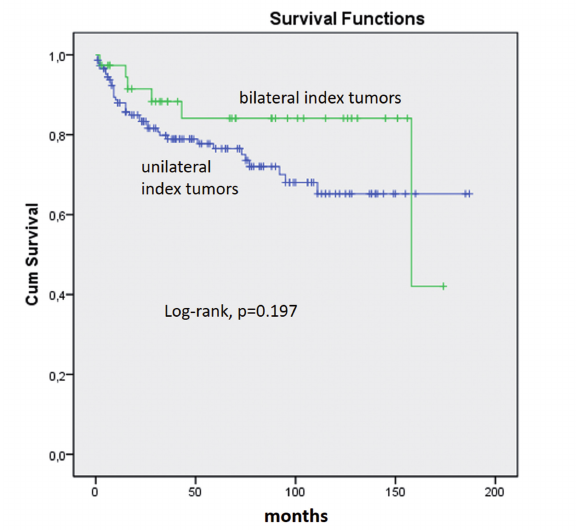
Figure 3 - Kaplan - Meier product limit analysis shows time to PSA biochemical progression - free outcome by laterality considering index tumor extent. Cum,